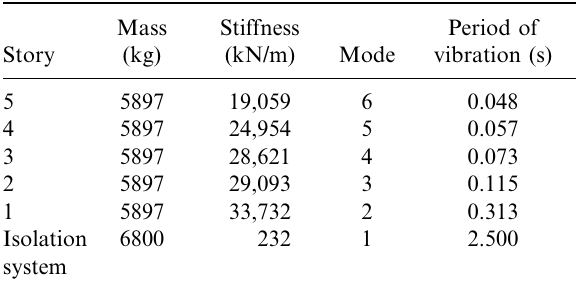
Table 1. MDOF system parameters (Kelly et al . 1987)